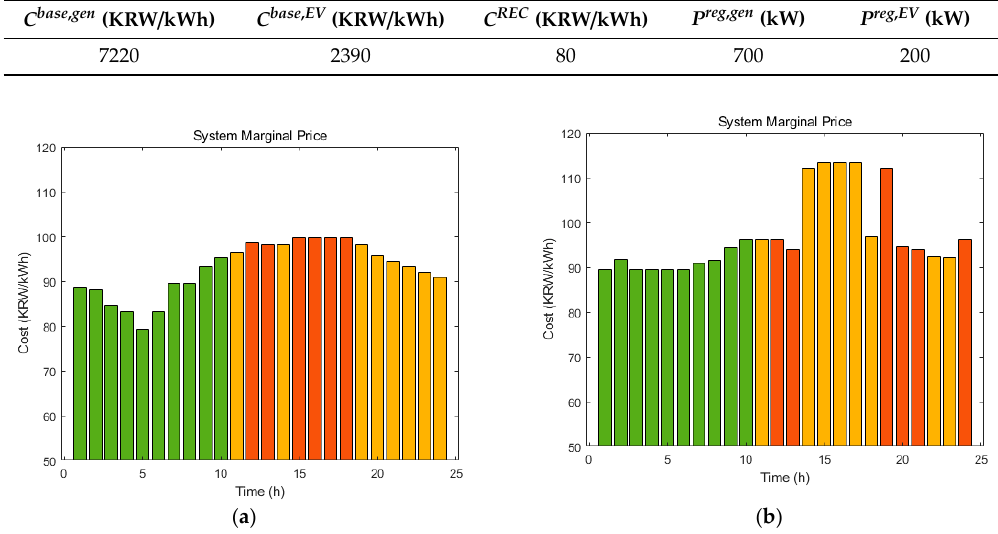
Figure 5. System marginal price (SMP): ( a ) 14 August 2017 (summer); ( b ) 25 January 2017 (winter).